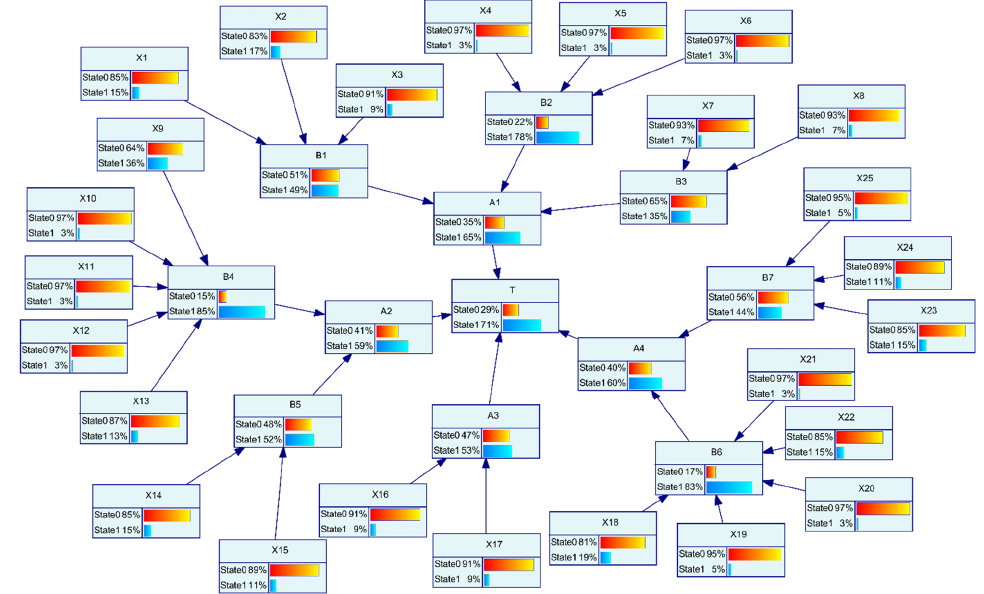
Figure 4. Prior probability parameters in BN model of BFG leakage accidents.